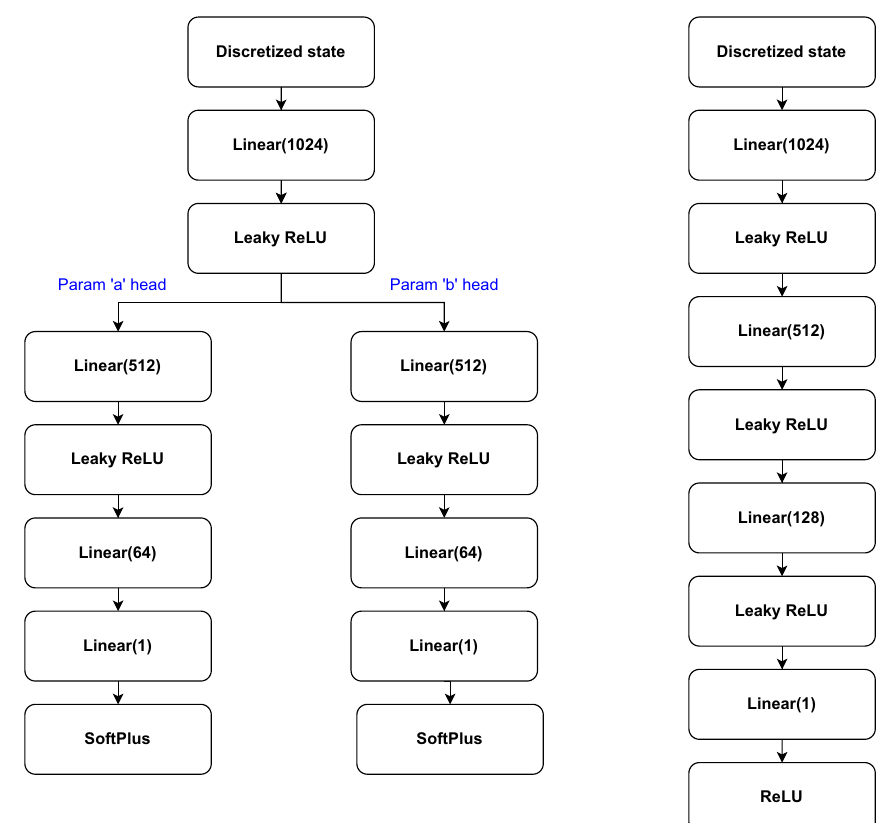
Fig. 1 The deep neural network architecture of the actor (left) and critic (right). Parameter heads a and b refers to the two branches of the actor network that returns the beta policy parameters a and